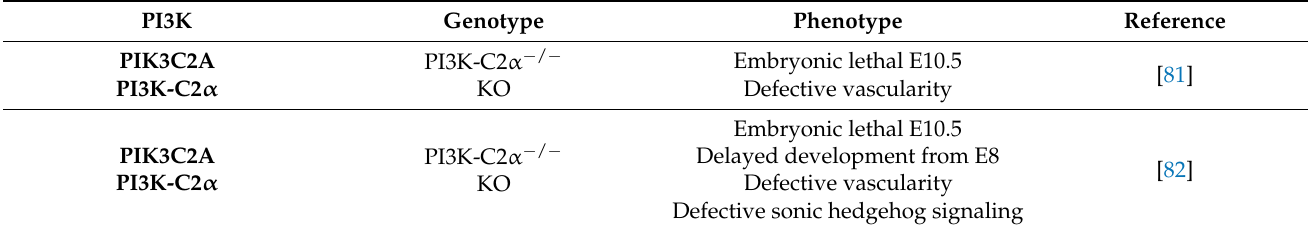
Table 1. Genetically engineered mouse models of class II PI3Ks (only systemic KO and KI mouse models were included in the